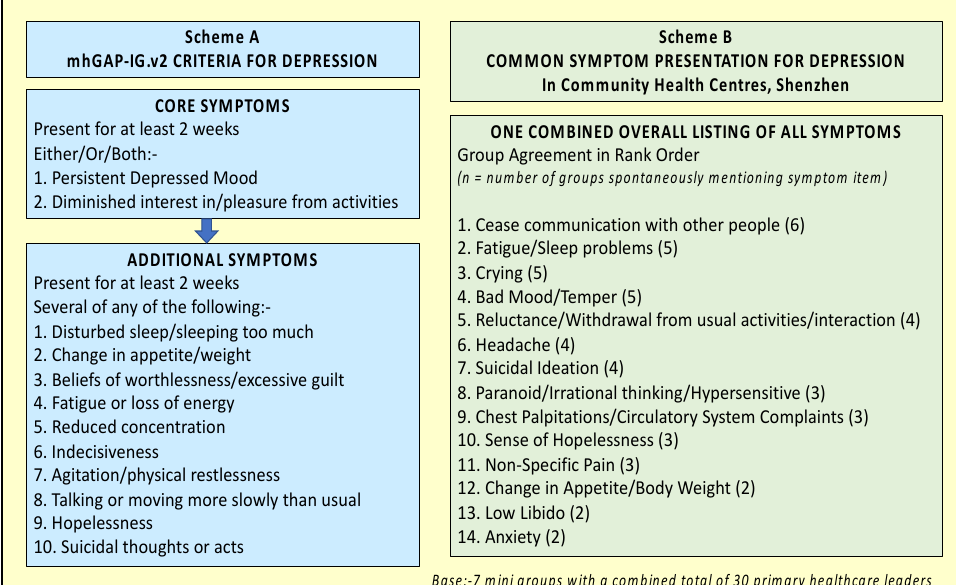
Figure 2. Comparison of mhGAP-IG.v2 criteria for depressive disorder (Scheme A) against Doctor Proposed Listing of Common Symptom Presentation for Depression In Community Health Centres, Shenzhen (Scheme B).